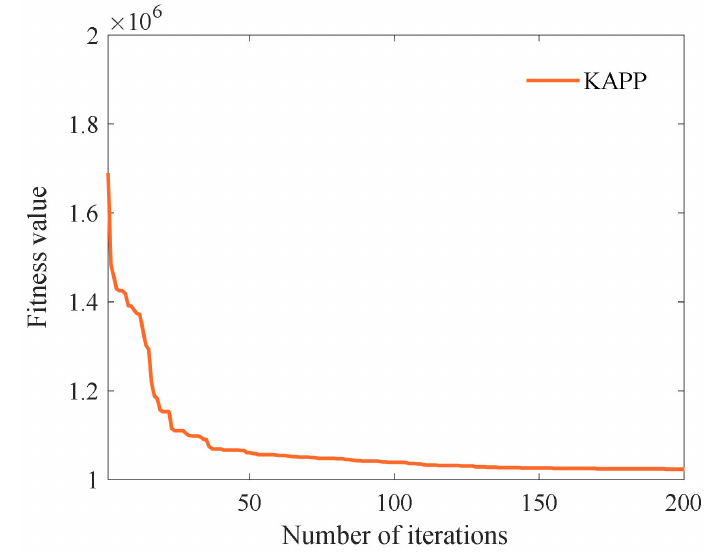
Figure 2. The fitness values of different iteration